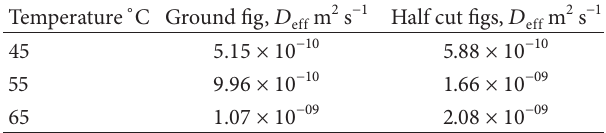
Table 1: Effective moisture diffusivity, 𝐷 ground figs and half cut figs at different temperatures.